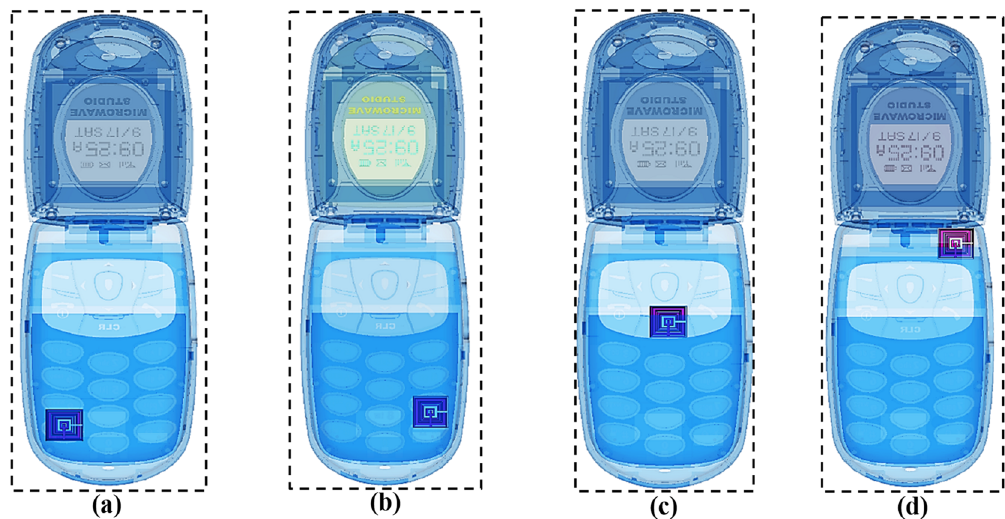
Figure 8. Multi-layer metamaterial structure in different positions inside the mobile phone: (a) Position 1, (b) Position 2, (c) Position 3, (d) Proposed. SAR 1 g (W/kg)